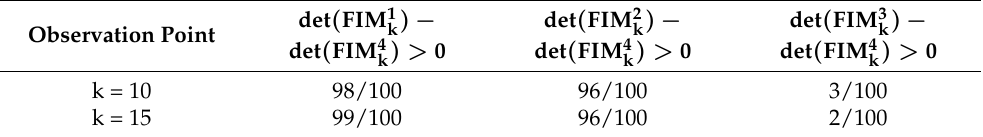
Table 1. Statistics that sum up the number of tests when det ( FIM i trajectory i at two observations.